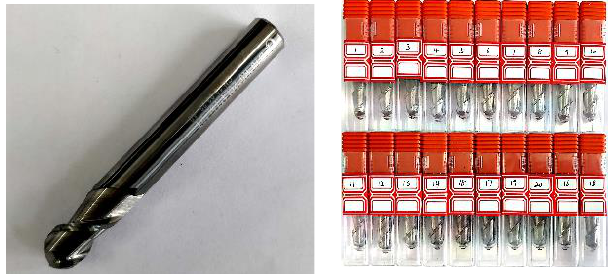
Figure 7. Experimental and spare tools.